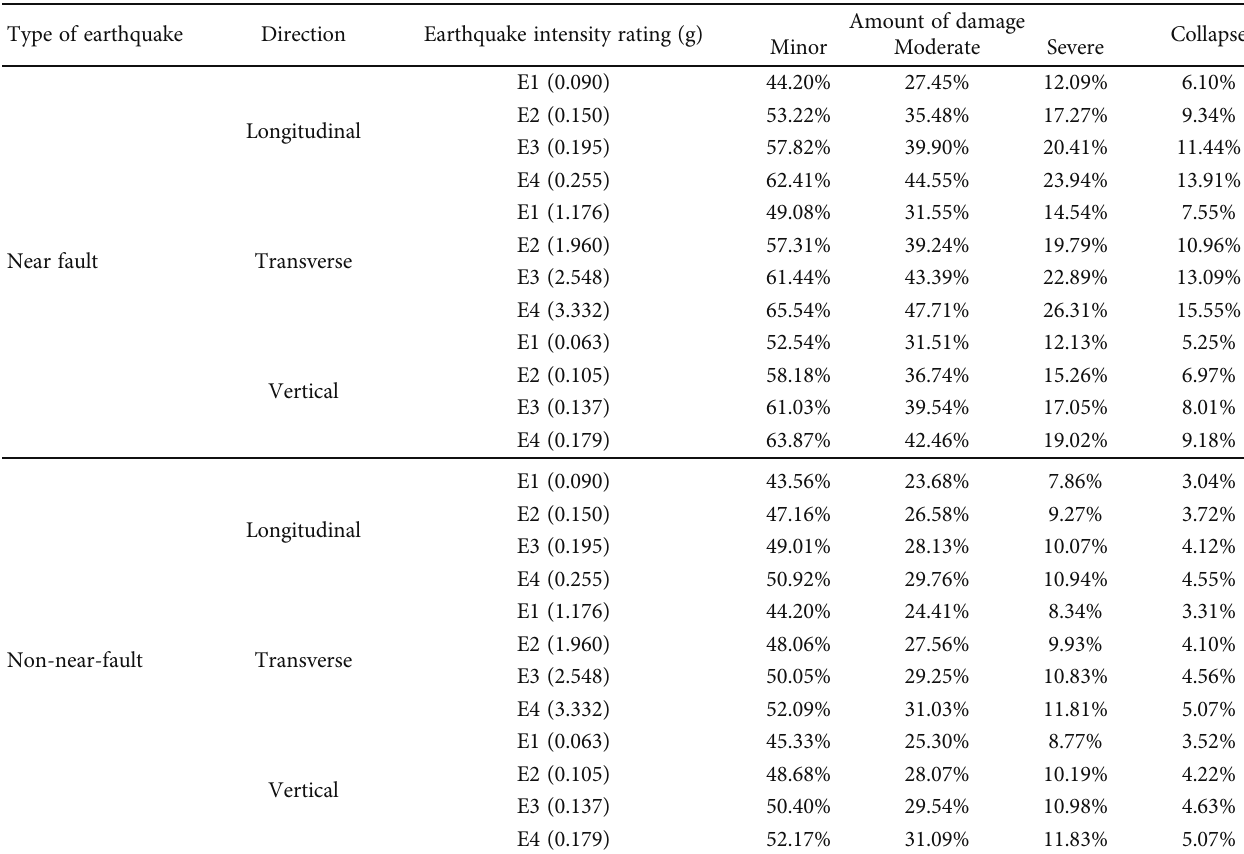
Table 7: Damage probability of various failure